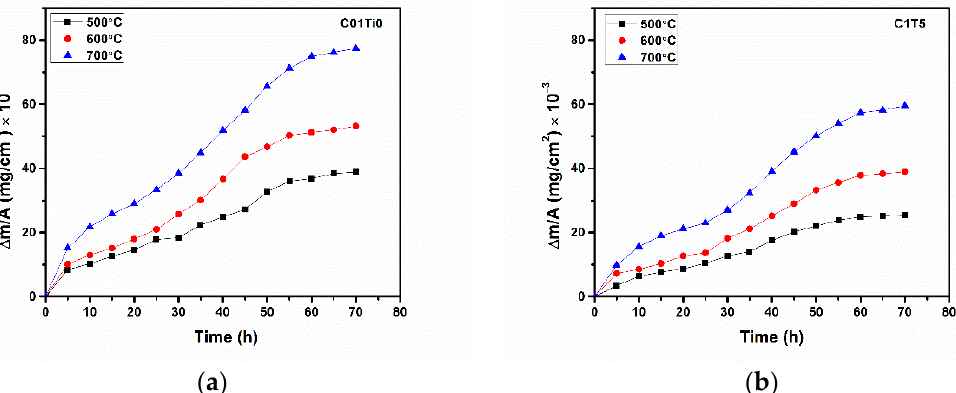
Figure 4. Comparative study showing the weight gain of ( a ) C01T0 and ( b ) C1T5 at different temperatures (Lines joining the data points are for visual aid only).